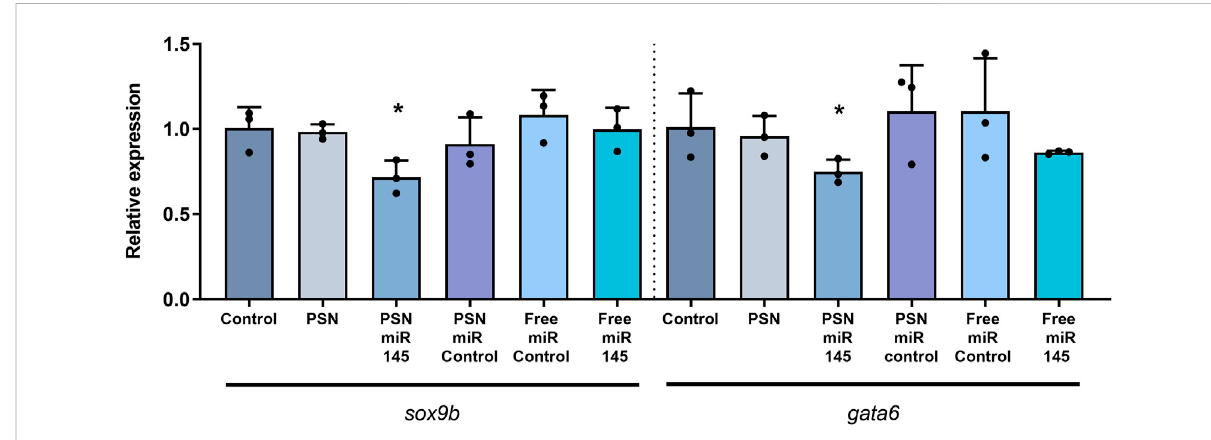
FIGURE 2 RT-qPCR results of the effect of miR 145 associated and non-associated with PSN in the relative expression of sox9b and gata6 genes in zebra fi sh